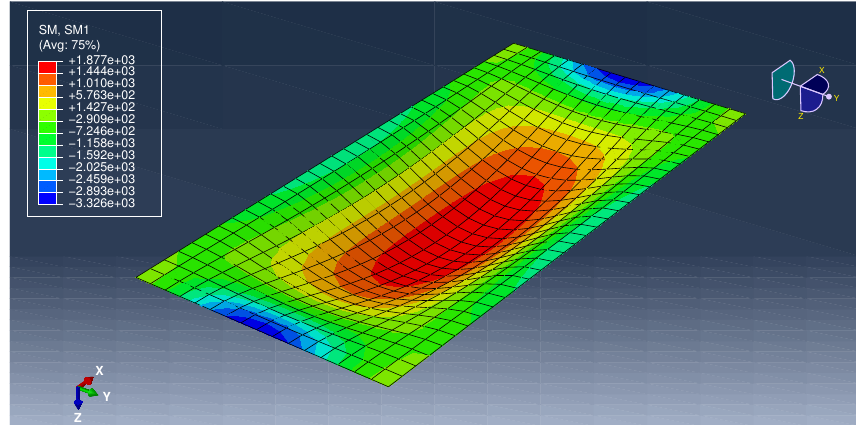
Figure A8. The bending moment M 11 of a rectangular plate with clamped edges solved using FEM.